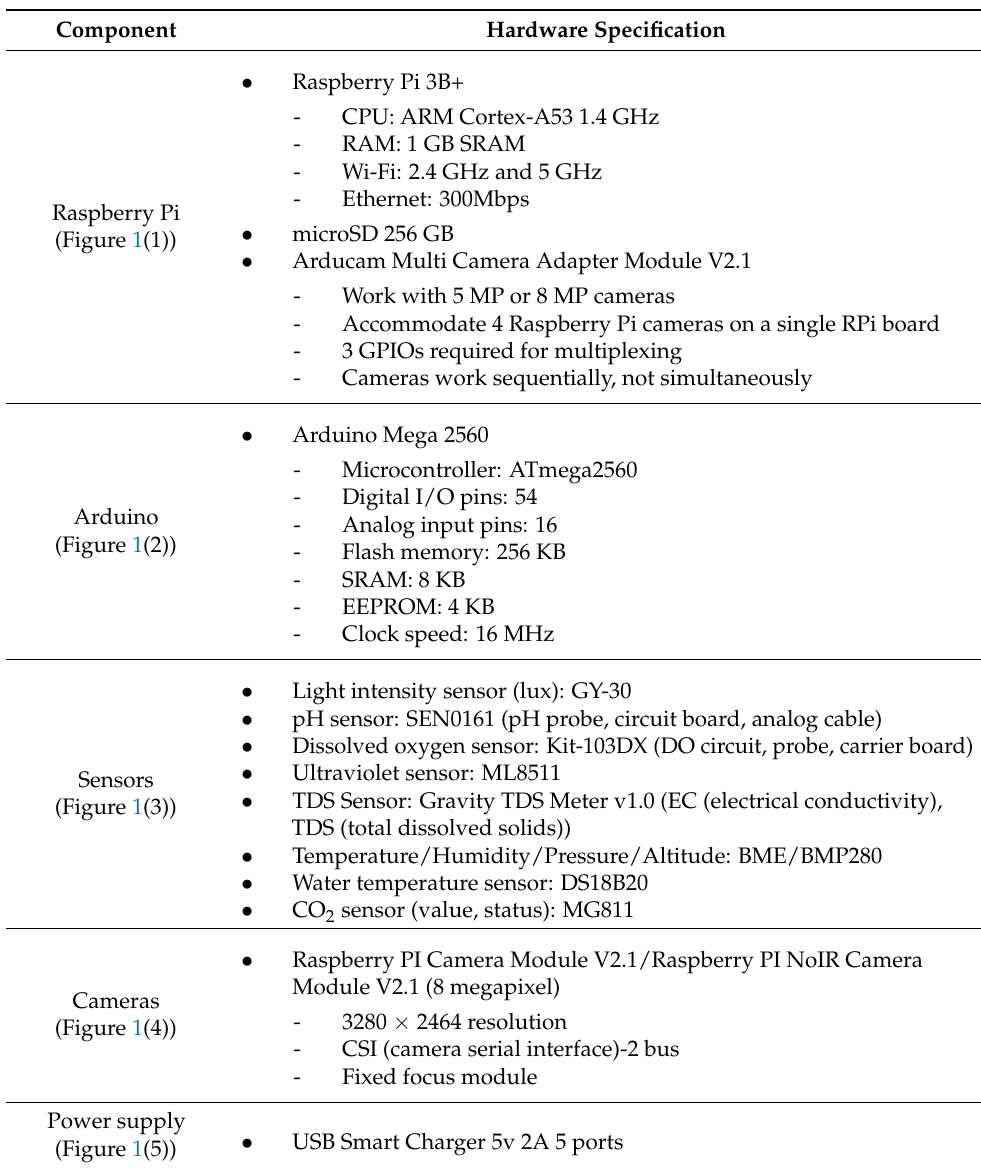
Table 1. The component hardware specification of the IoT-Edge